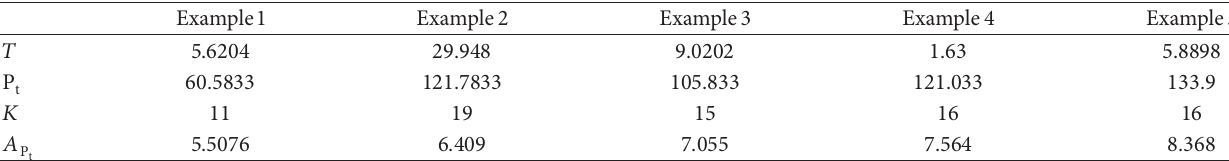
Table 7: Computational results of ATGH.